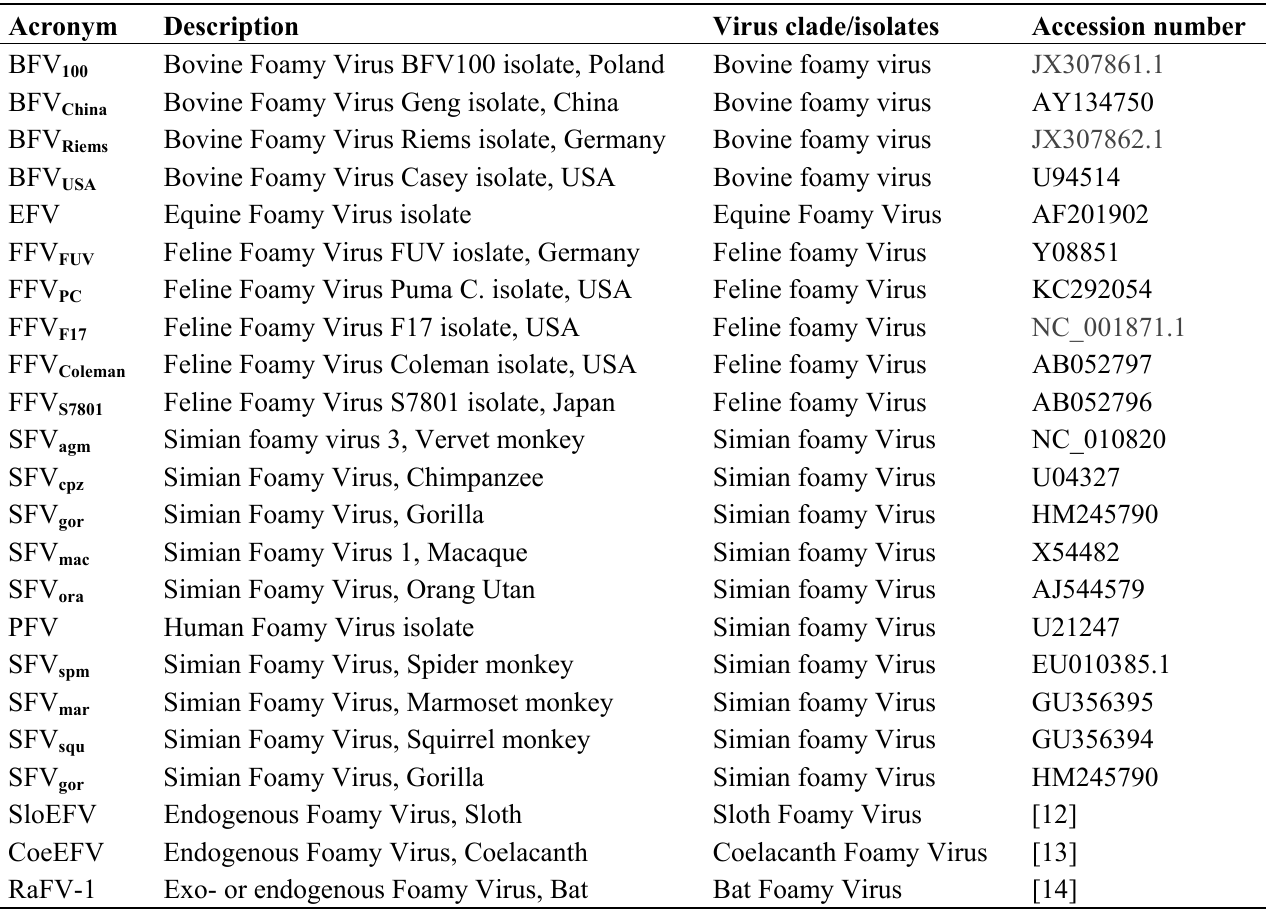
Table 2. Accession numbers and references used for FV